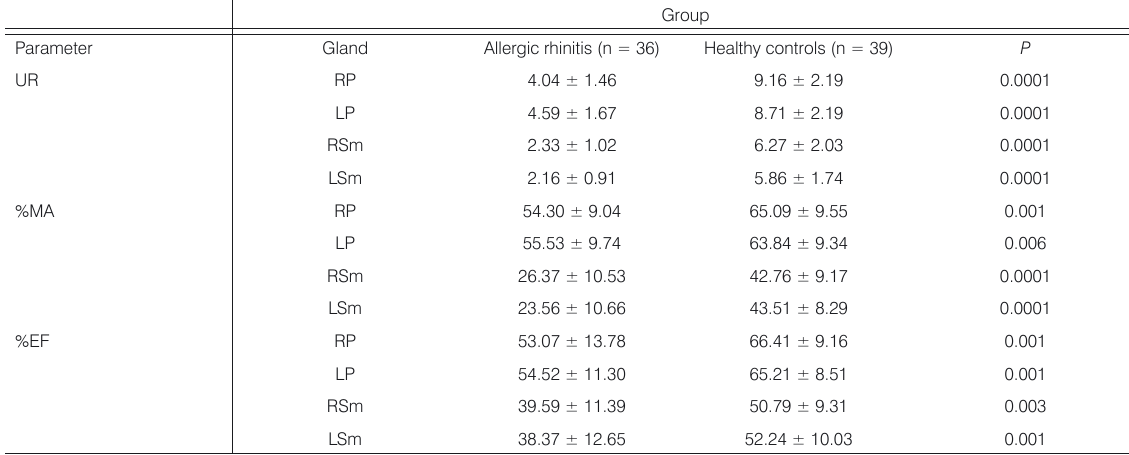
Table 2. Comparison of scintigraphic parameters in patients with allergic rhinitis and healthy controls.